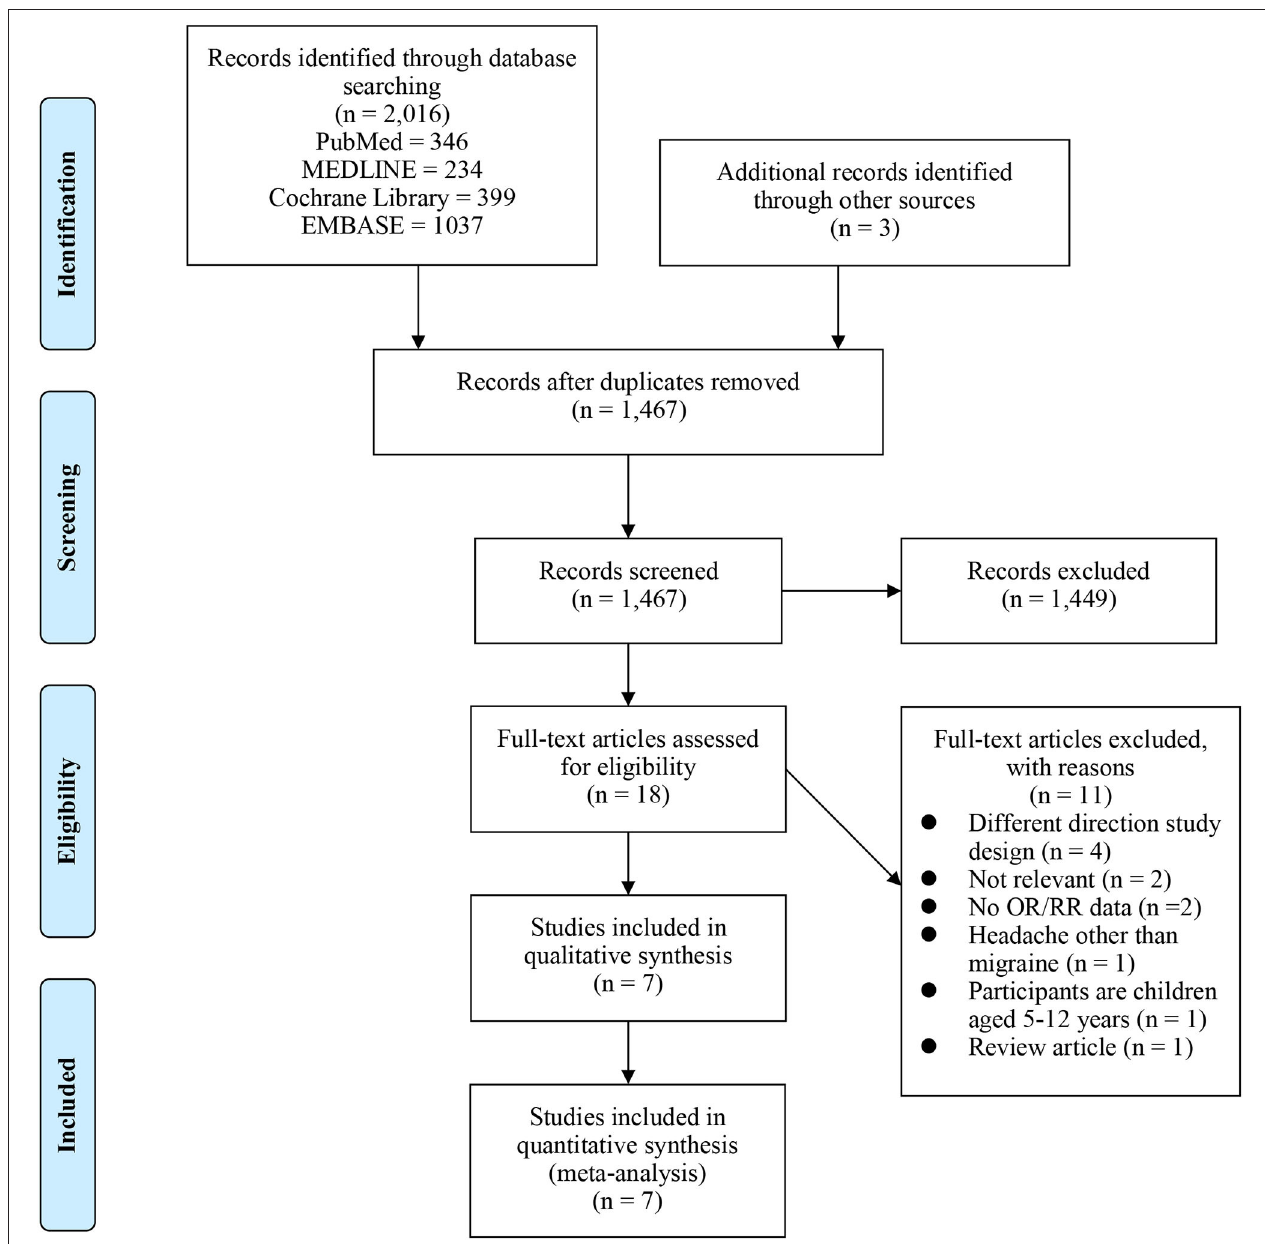
FIGURE 1 | Preferred Reporting Items for Systematic Reviews and Meta-Analyses (PRISMA) study flow